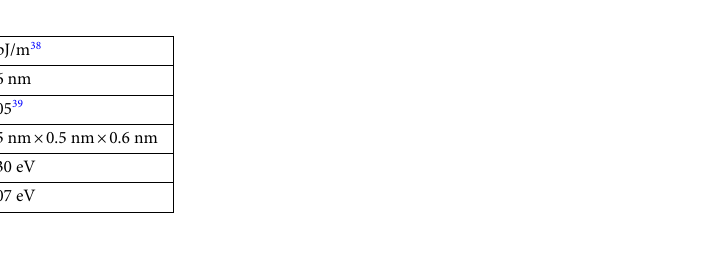
Figure 5. ( a ) Voltage pulse described in terms of PMA for switching of 20 nm nanodot in the presence of thermal perturbation; magnetization states corresponding to the PMA energy at different times are shown below the pulse diagram. ( b ) Switching percentage vs. pulse width (all of the points show the switching percentage for 100 simulation cases except the point marked with asterisk on the blue line. The star mark corresponds to a 67 ps pulse width where the simulations were run for 1000 times and 68 failures indicate ~ 93% switching) and ( c ) 20 nm nanodot with 5% edge roughness at the boundary.